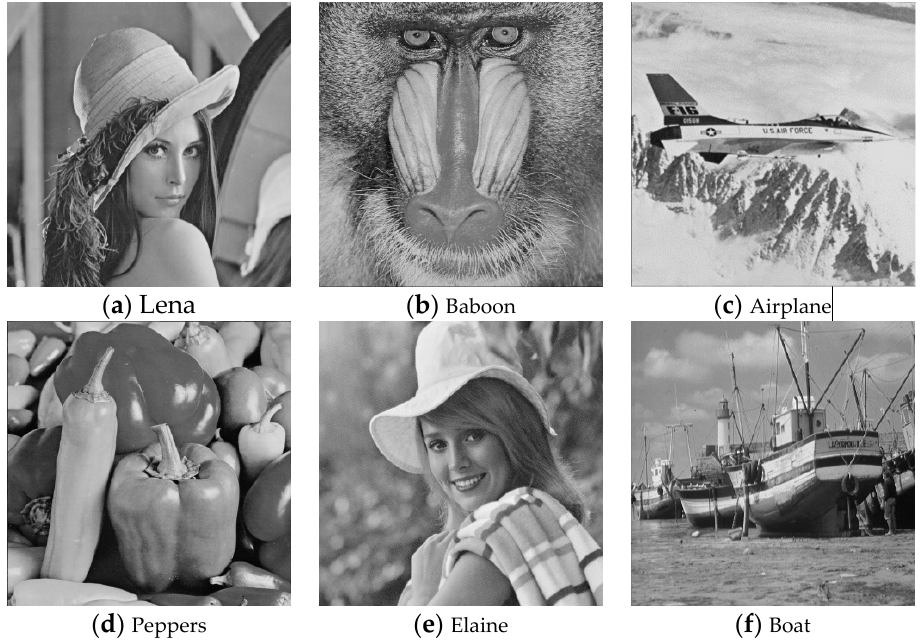
Figure 5. Cover images, each of size 512 × 512 pixels.